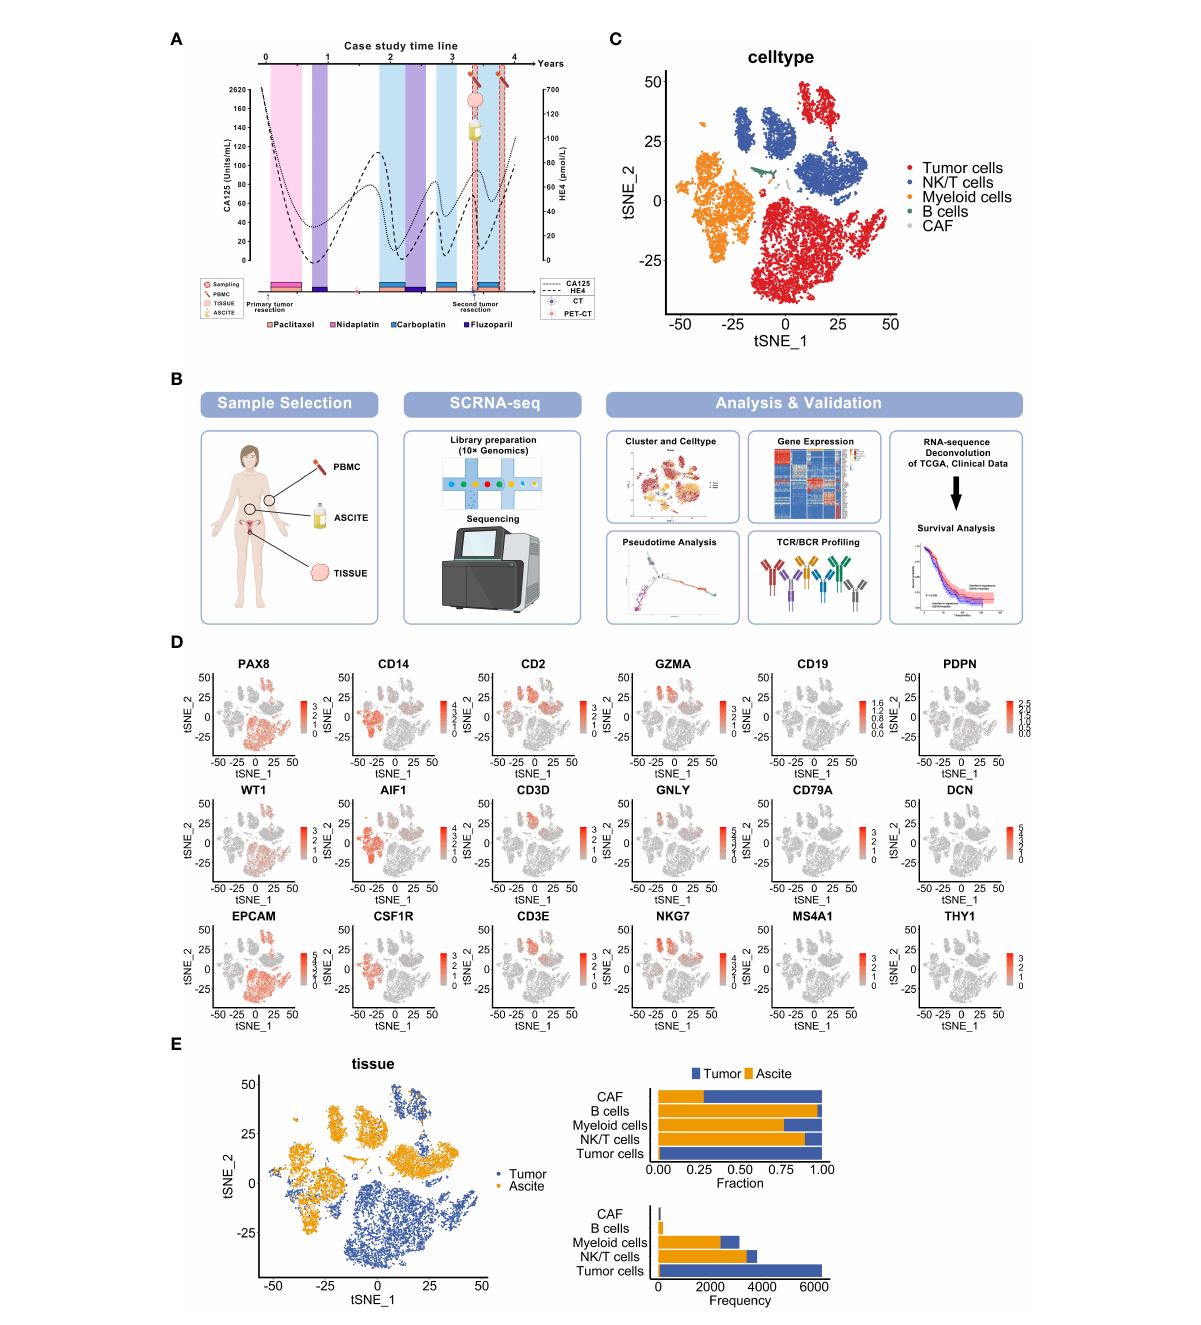
FIGURE 1 Single-cell sequencing to characterize the diverse cellular components of specimens derived from a recurrent ovarian cancer patient. (A) Overview of the clinical course and sample collection time of an HGSOC patient. The curved lines indicate changes of tumor biomarkers (CA125, HE4). The timepoints of chemotherapy treatment are shown in the label. (B) Overview of the sample collection, pro fi ling strategy and analysis work fl ow. (C) t-SNE visualization of diverse cell types in sample Tumor and Ascite , colored by each cell type. (D) t-SNE plots show cell- type marker genes expression level. (E) t-SNE visualization of cells from samples Tumor and Ascite , colored by sample origin (left panel). Fraction and frequency of cells (x axis) from tumor tissues and ascites in each cell type (y axis) (right